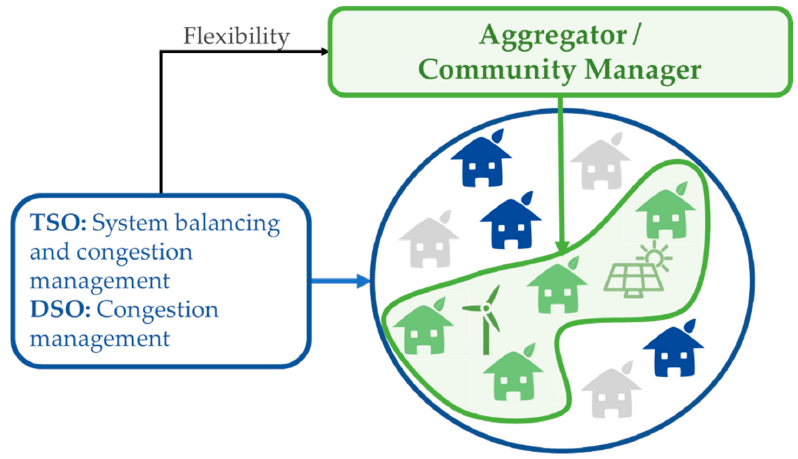
Figure 1. The simplified interaction between different entities.